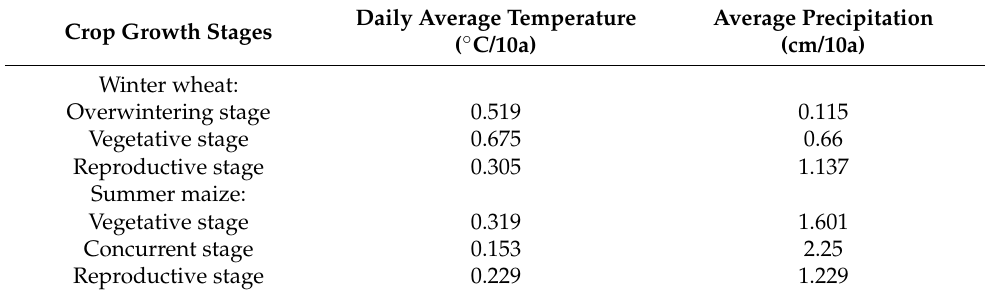
Table 3. Climatic trend rate of major crop growth stages in the NCP (1981–2010). Daily Average Temperature Average Precipitation Crop Growth Stages ( ◦ C/10a)